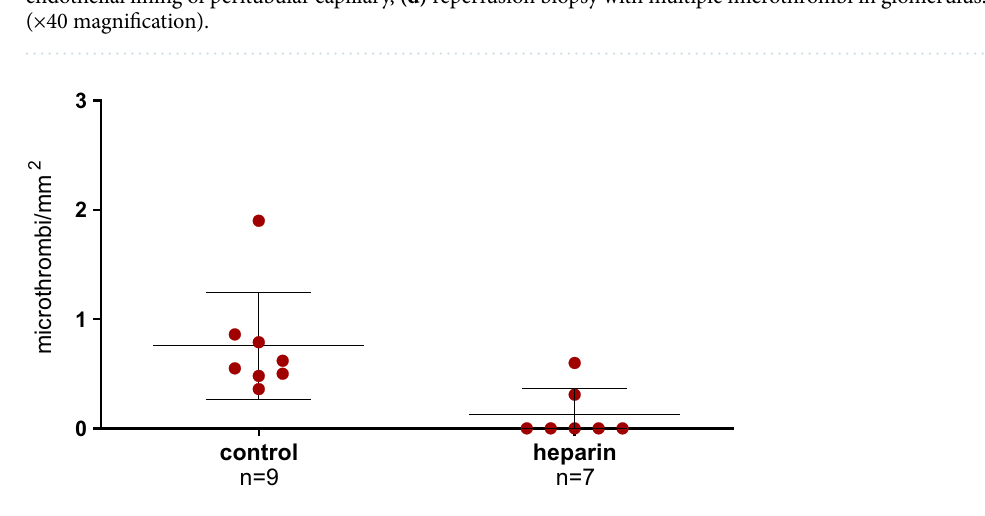
Figure 6. microthrombi/mm 2 in LDK biopsies after reperfusion. Data are shown as median with 95% confidence interval. microthrombi/mm 2 , microthrombi per square millimeter; p =